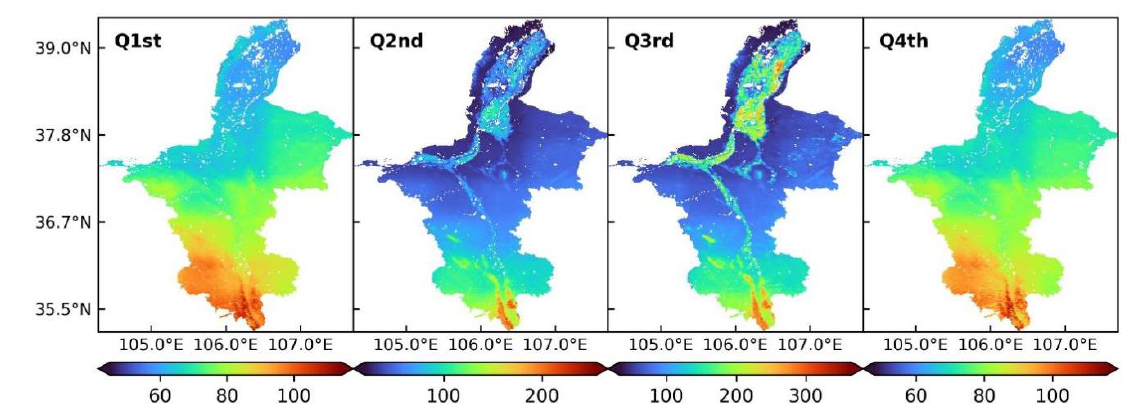
Figure 5. Spatial distributions of quarterly ET in Ningxia from 2001 to 2020.